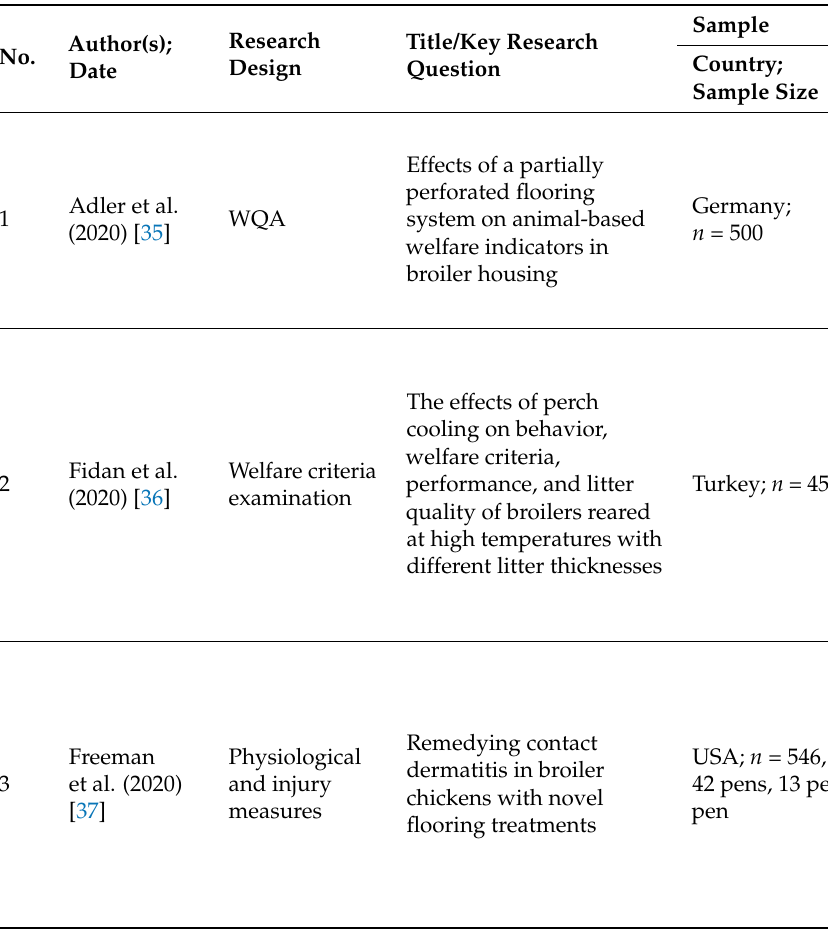
Table 4. Studies (10) suggesting means of enhancing welfare in litter floor systems. Nb: Stocking densities were not converted into consistent measures due